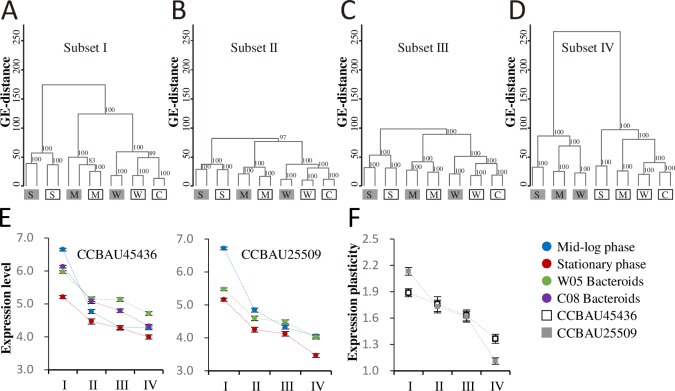
Condition-dependent transcriptional profiles of S. fredii CCBAU45436 and CCBAU25509 under free-living and symbiotic conditions.(A-D) Clustering analyses of Log2-transformed RPKM values for genes within different hierarchical core/accessory subsets (I-IV) using the average linkage method based on Euclidean distance. CCBAU45436 and CCBAU25509 are represented by white and grey boxes respectively. S, stationary phase; M, mid-log phase; W/C, microsymbionts in nodules of G. soja W05 or G. max C08. Bootstrap values above 70% are indicated. (E) Gene expression level within different hierarchical core/accessory subsets under test conditions, dots and error bars refer to the means and standard errors of Log2-transformed RPKM values. (F) Gene expression plasticity within different hierarchical core/accessory subsets under test conditions, dots and error bars refer to the means and standard errors of variances of Log2-transformed RPKM values. Multi-copy genes were not included in these analyses.